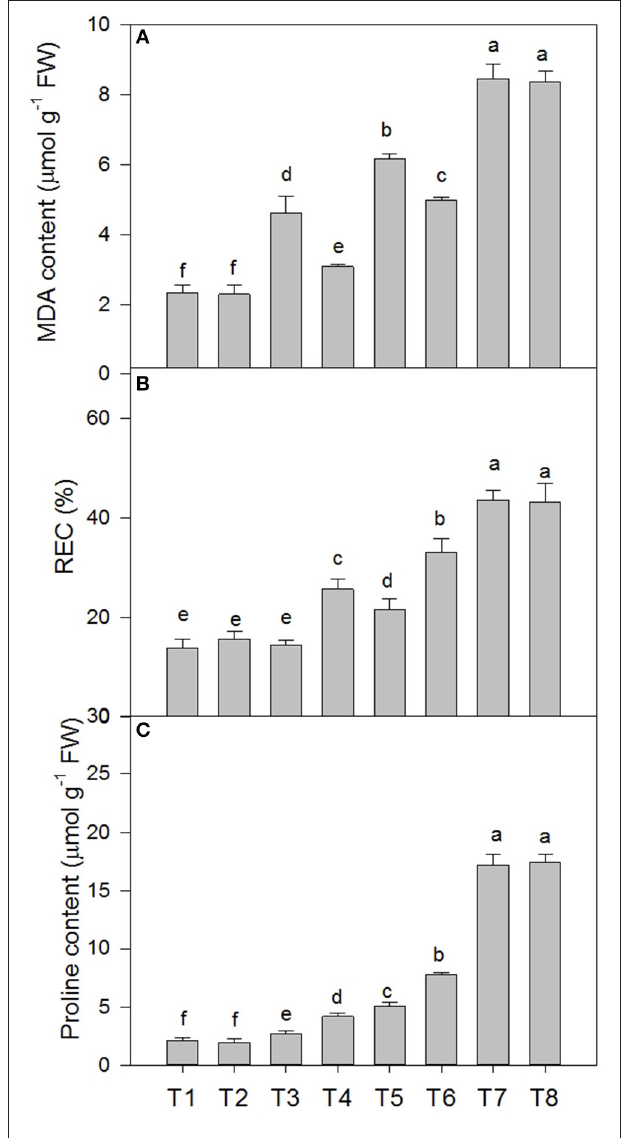
FIGURE 3 | Effects of SA on the malondialdehyde (MDA) content (A) , relative electric conductivity (REC) (B) , and proline content (C) of D . superbus grown under salt stress (means ± SD). Different letters indicate significant differences ( P < 0.05) according to an LSD-test; the same letter indicates